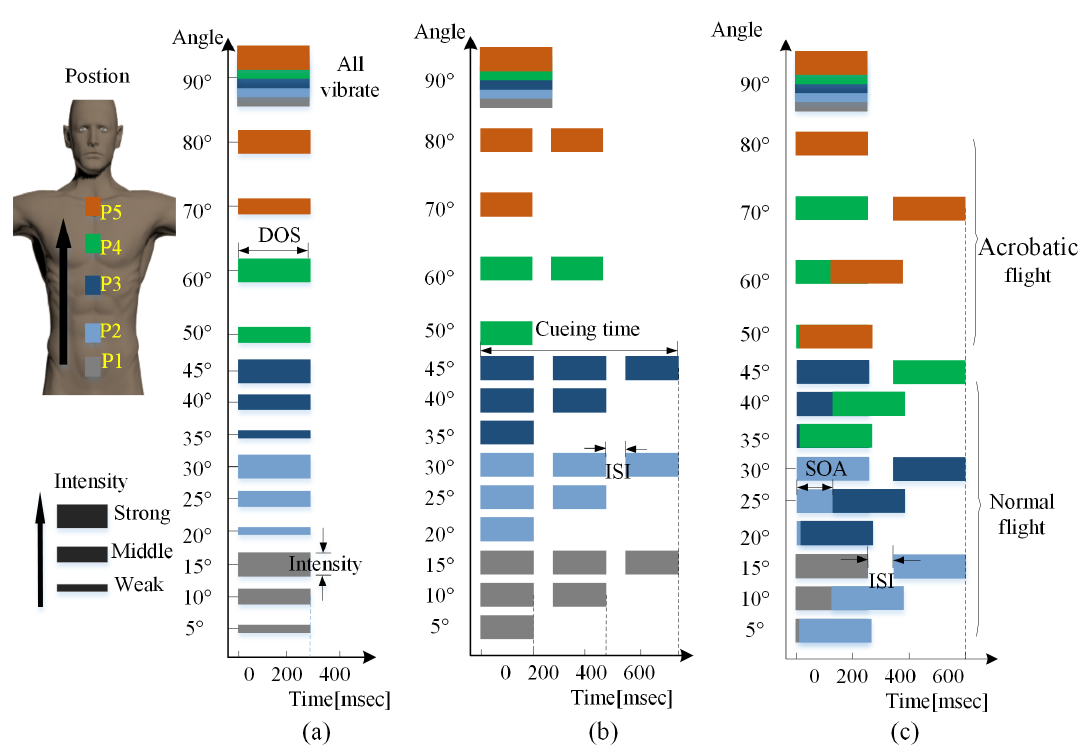
Figure 6. Schematic diagram of coding methods with combination of two parameters: ( a ) location and intensity (LI); ( b ) location and rhythm(LR); ( c ) location andmode(LM). For the convenience of labelling angel intervals, five degrees in vertical coordinate indicates interval [5, 10) in Table 3, 10 indicates [10, 15), and so forth. The cueing time is maximum time to convey a vibrotactile pattern. Different colour blocks represent tactors locating at different sites in a